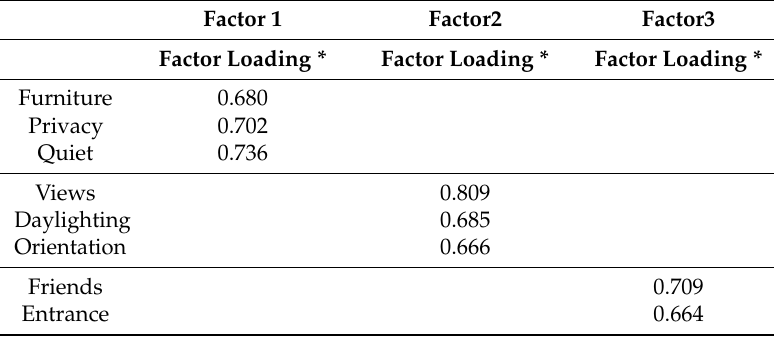
Table 1. Three underlying factors for choosing seats.